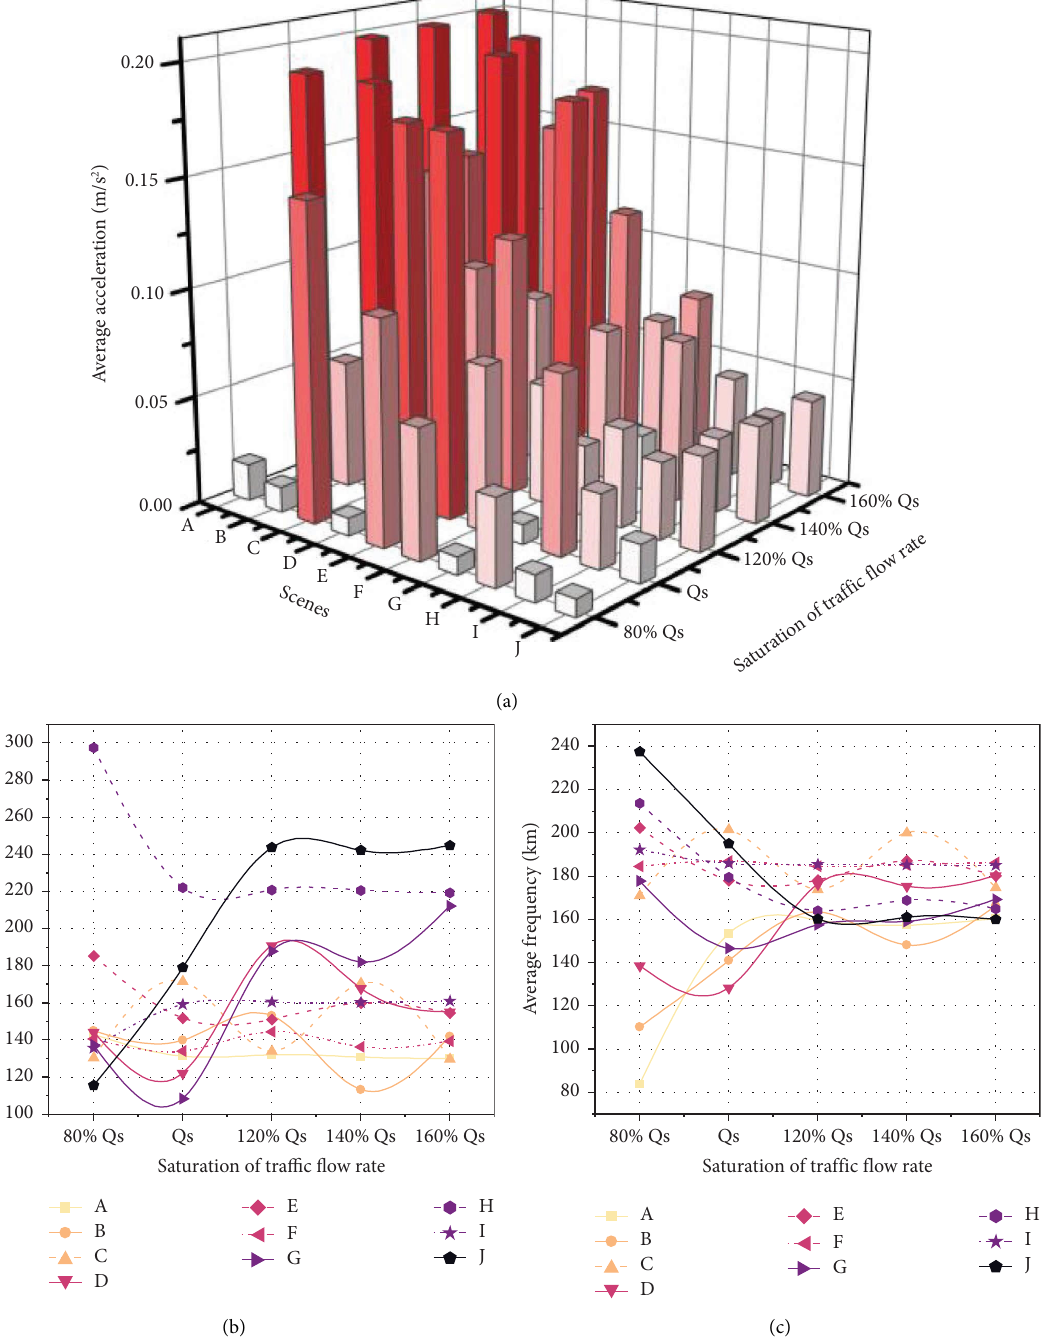
Figure 6: Te average accelerations (a), average negative acceleration’s frequencies (b), and average positive acceleration’s frequencies (c) in diferent scenes under diferent trafc